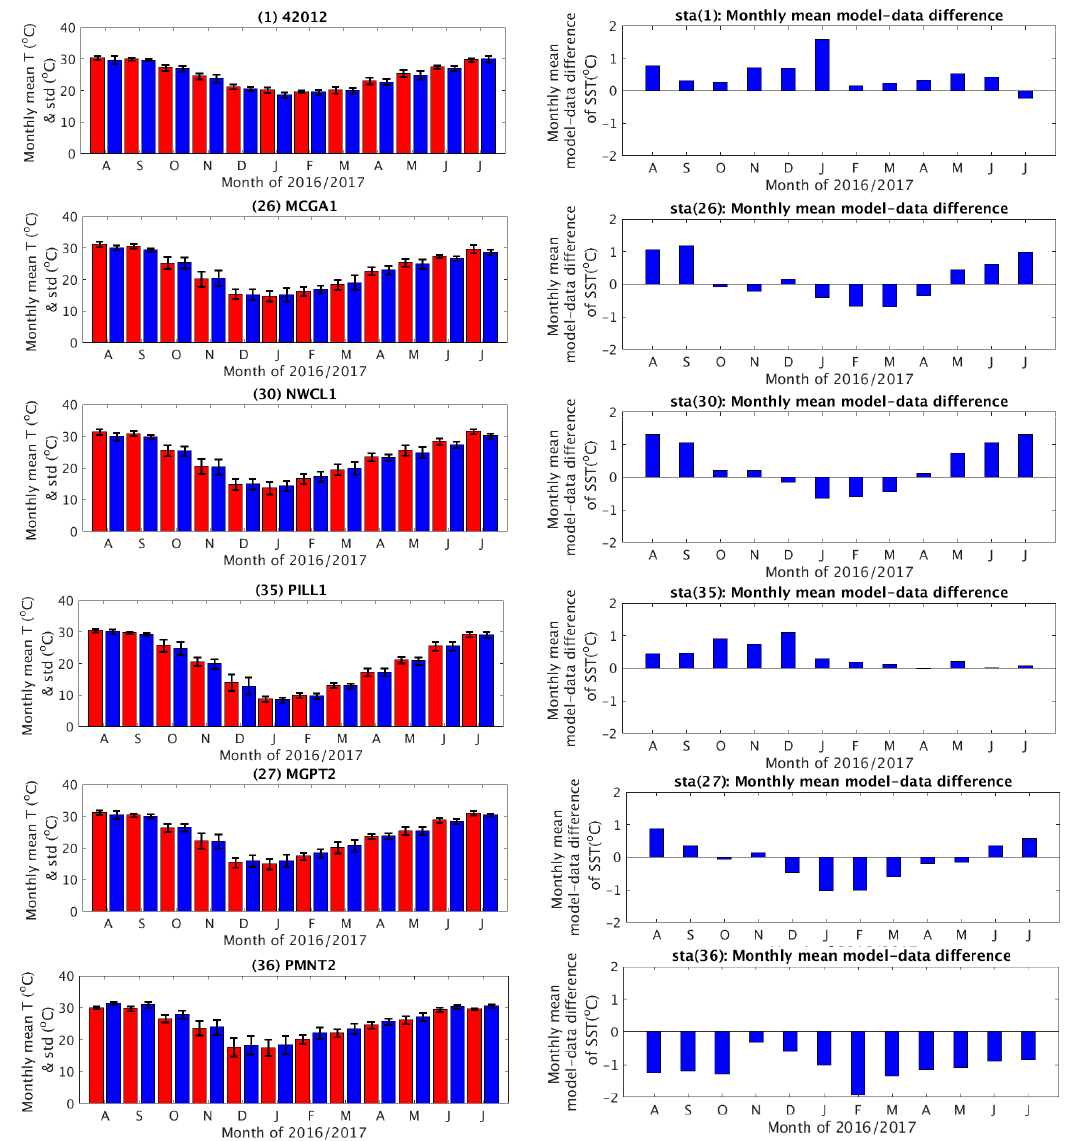
Figure 12. Left panel—Comparison of monthly model output mean SST (red bars), and monthly observed mean SST (blue bars), and the standard deviation of each data set. Right panel—monthly mean model bias. The station IDs are shown in the title of each plot. See the station locations in Figure 1.